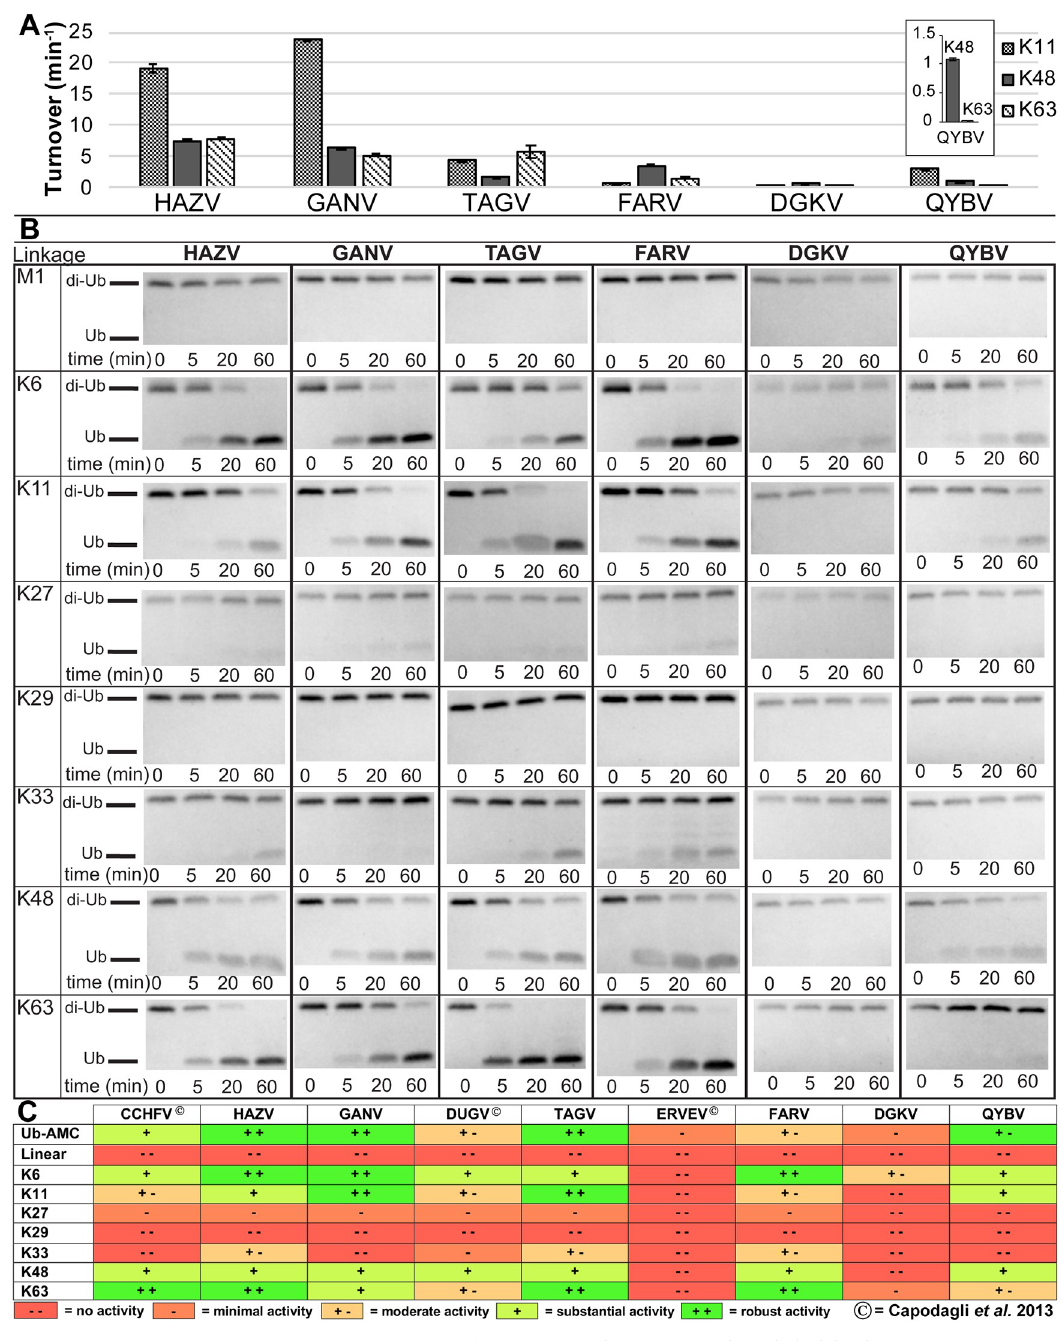
Fig 3. vOTU preferences for different di-Ub linkages. (A) Activity towards K48, K63, and K11 linked di-Ub FRET-TAMRA substrates. Values shown are the mean ± standard deviation of two independent experiments. (B) Gel cleavage assay of unlabeled di- Ub, visualized by Commassie Blue staining. (C) Summary of currently investigated vOTU di-Ub activity (present study and